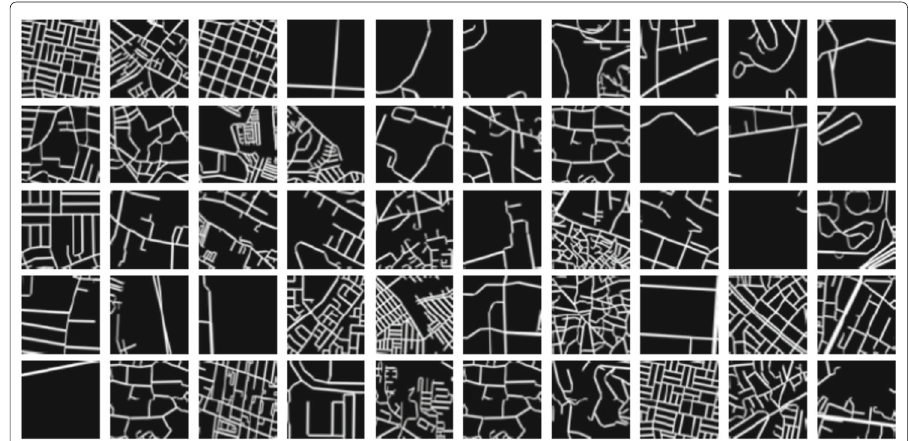
Fig. 3 Example images of the street network in randomly selected cities, shown as a square window of 3 × 3 km centered on the city